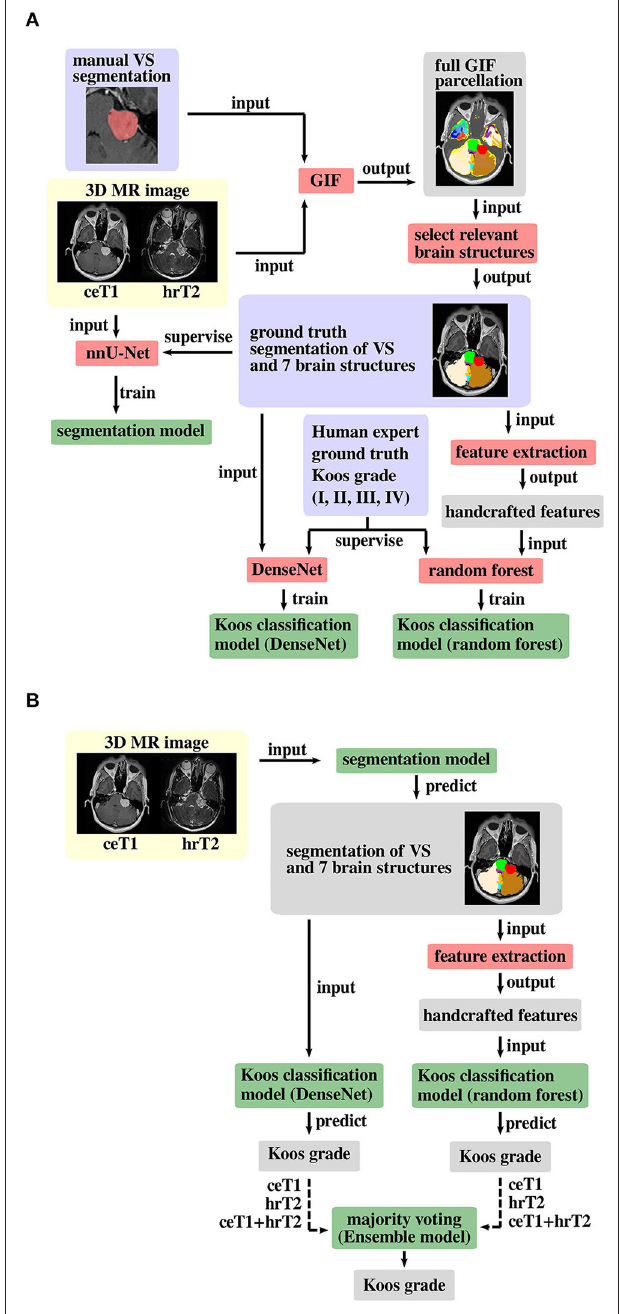
FIGURE 2 | Proposed pipeline for (A) model training and (B) inference. The background colors indicate pre-processed MR images (yellow), algorithms/operations (red) applied to input data, ground truth data (blue) that is used to supervise the model training process, intermediate output data (gray) and trained models (green). Training of both Koos classification models is only required for an ensemble model of DenseNet and Random Forest, otherwise either model can be applied individually, and the other model’s pipeline branches can be omitted for training and inference. The dashed arrow lines in the inference pipeline indicate that the whole pipeline (including training) must be run with each of the three different input types to obtain three Koos grade predictions per